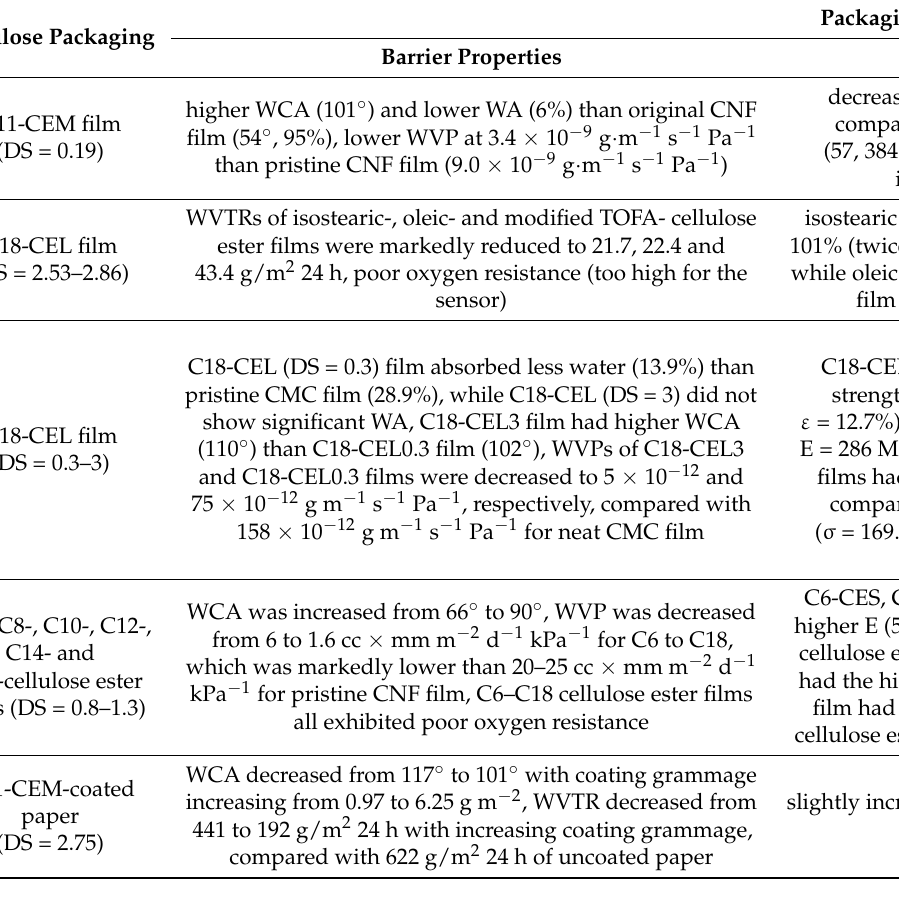
Table 5. Overview of cellulose ester (C2–C18) materials in food packaging